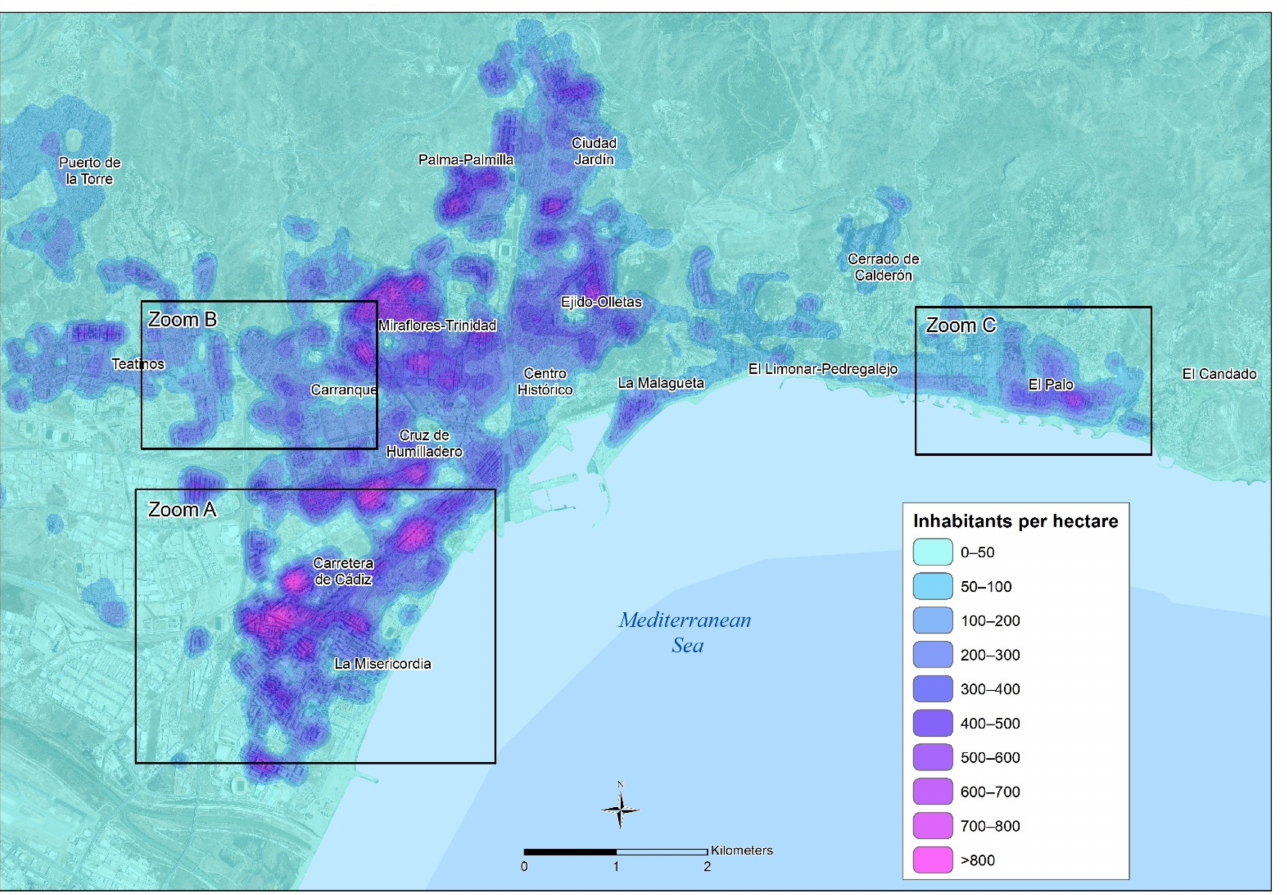
Figure 13. Population density map. Own